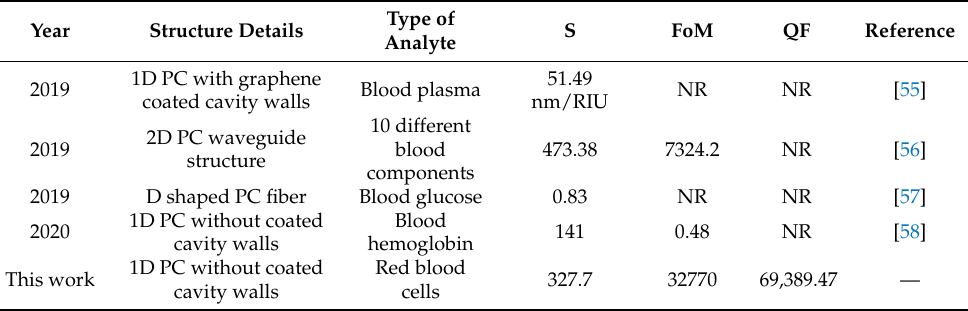
Table 4. Comparison of sensitivity, figure of merit and quality factor values of proposed 1D photonic blood sensor for malaria sensing and detection with similar kinds of work of other researchers at normal incidence (NR = Not